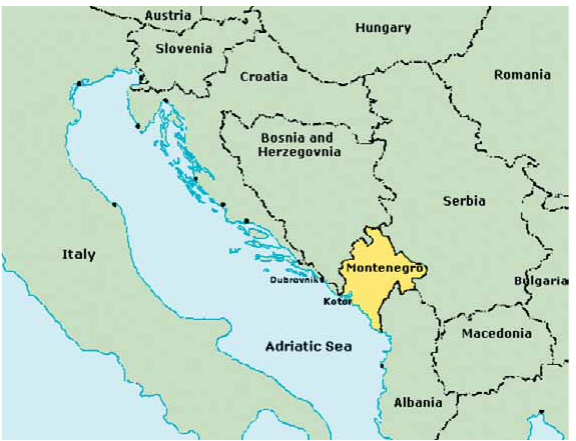
fig. 1. Map of former Yugoslavia fig. 2. Boka Kotorska